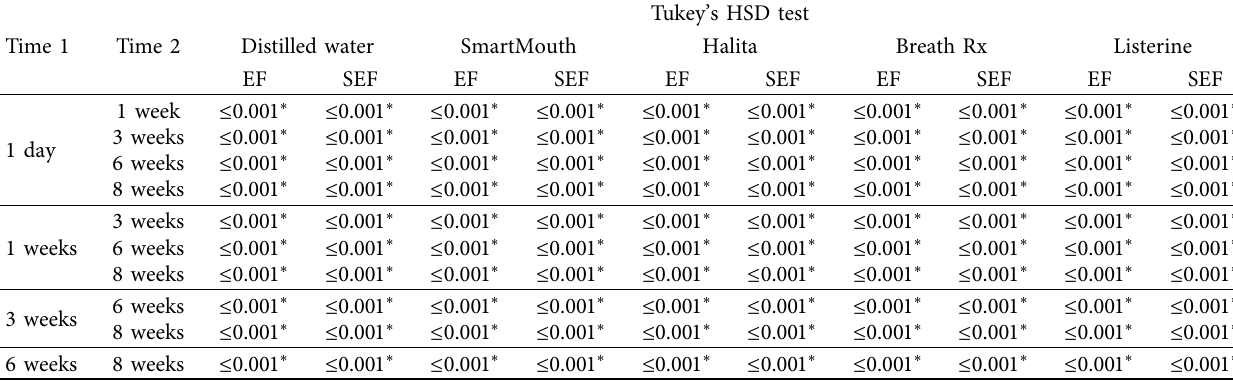
Table 4: Tukey’s HSD test for comparison between each two-time interval.